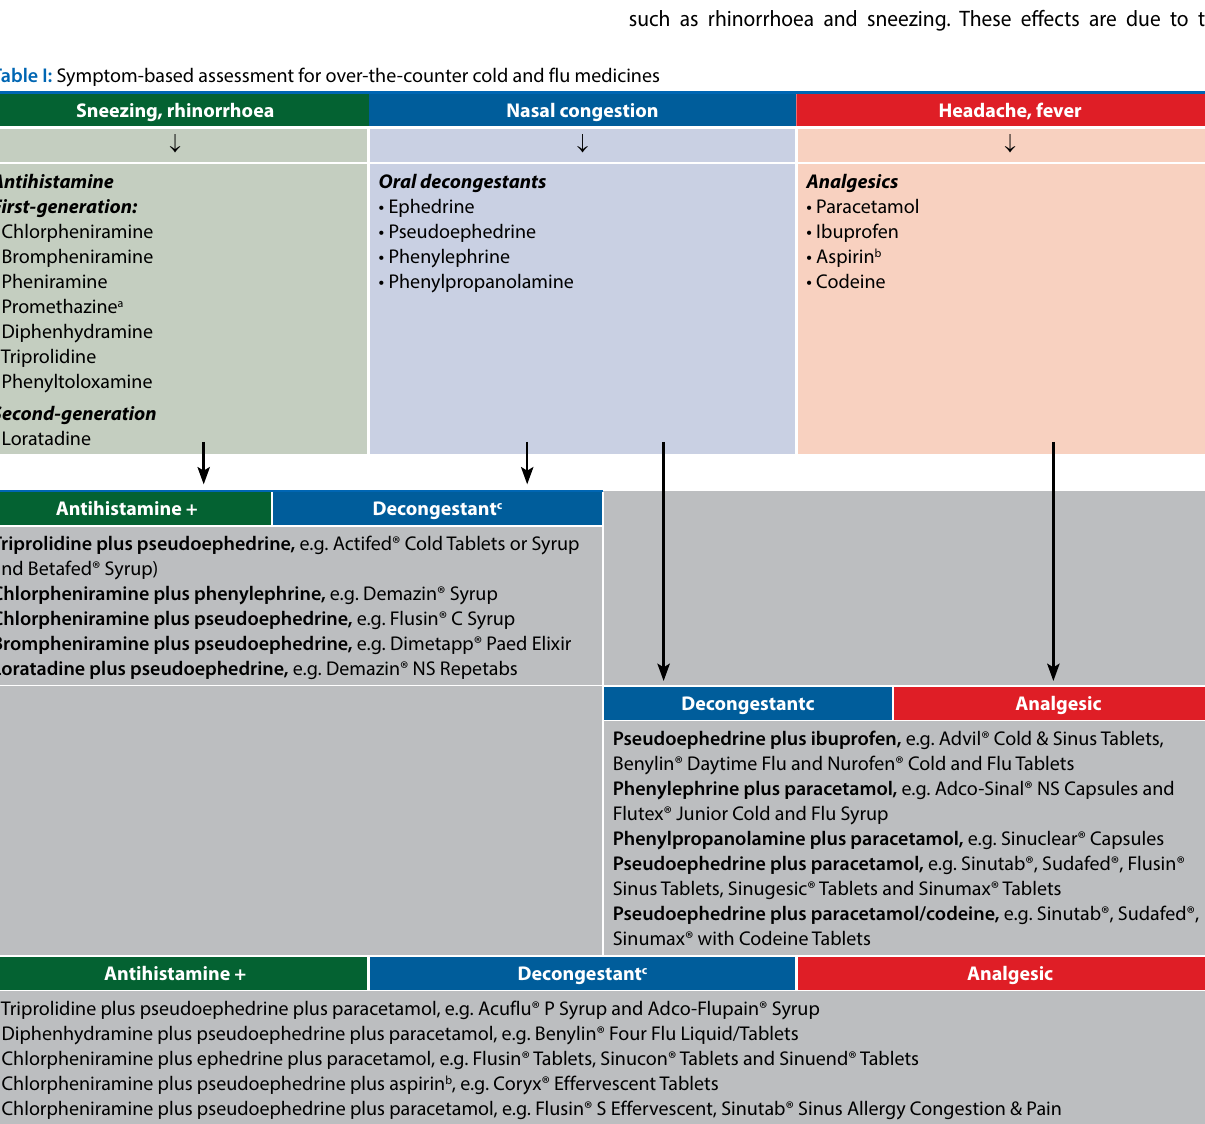
Figure 1: Natural history of the common